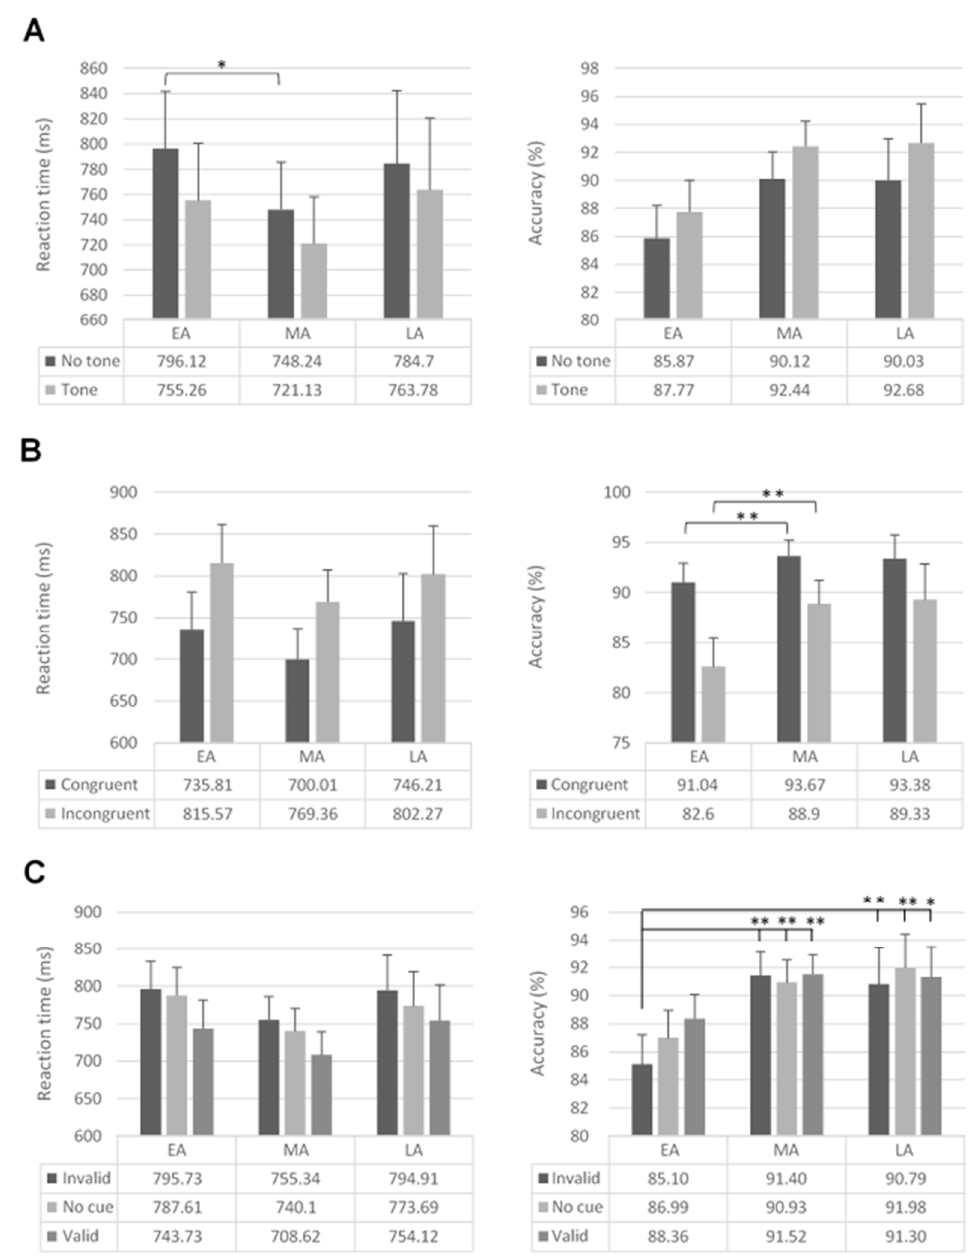
Figure 2. Mean reaction times ( left ) and percentage of accuracy ( right ) in the three groups of participants (early adolescents, middle adolescents, late adolescents) for ( A ) warning condition, ( B ) executive control condition, and ( C ) cue condition. Error bars represent standard errors. * p < 0.05; ** p < 0.01.